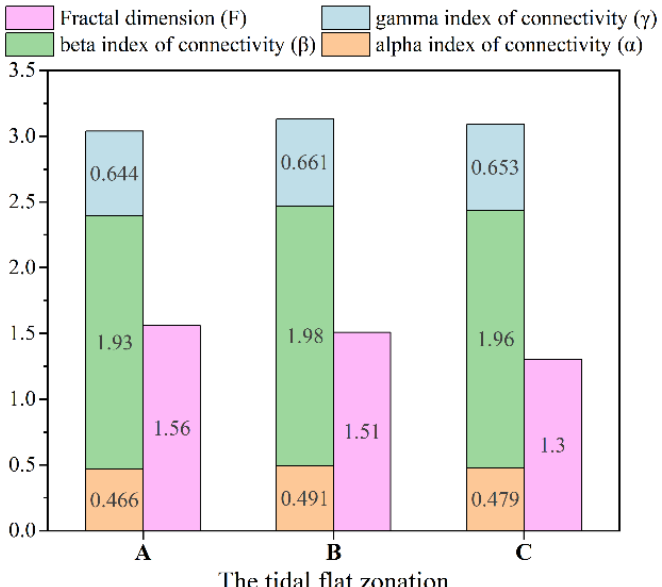
Figure 11 gives the connectivity and fractal dimension of the tidal creek network in each tidal zone in the LRE. In the supratidal zone, the connectivity of the tidal creek network is the lowest but the fractal dimension of the tidal creek network is the highest (F = 1.56). In the upper intertidal zone, the connectivity of the tidal creek network is the highest (the values of α , β , and γ are 0.49, 1.98, and 0.66, respectively) and the fractal dimension of the tidal creek network is equal to 1.51. In the middle intertidal zone, the connectivity of the tidal creek network is higher than that in the supratidal zone but lower than that in the upper intertidal zone. The fractal dimension of the tidal creek network is the lowest (F = 1.3) in the middle intertidal zone, suggesting that the fractal dimension of the tidal creek network decreases significantly with a declining beach surface elevation gradient. Overall, in the coastal wetlands of the LRE, the tidal creek system in the upper intertidal zone has the strongest hydrological connectivity but the tidal creek system in the supratidal zone is the most complex.